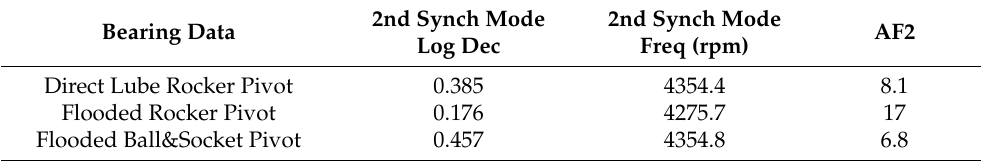
Table 7. Rotordynamics Comparison—2nd